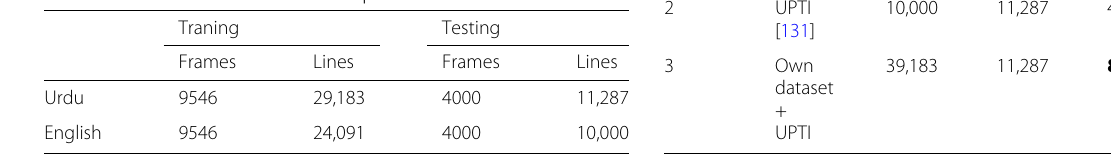
Table 5 Distribution of data for script